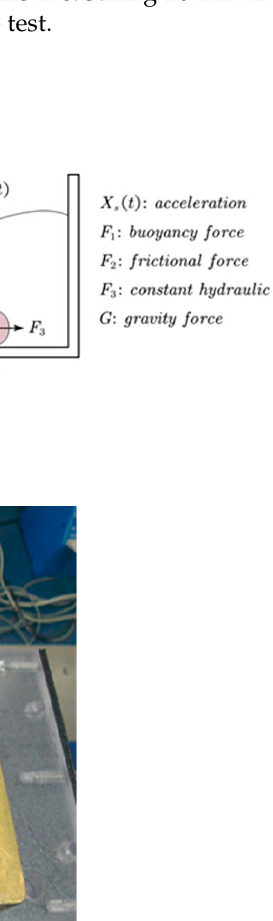
Figure 2. PDAL system (actual photo).